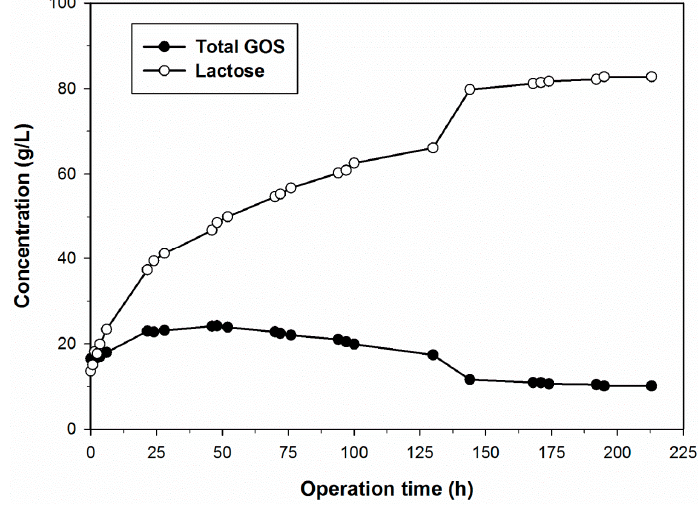
Figure 5. Progress of GOS and lactose concentration during the operation of the PBR (packed ‐ bed reactor) packed with β‐ galactosidase from B. circulans immobilized on glyoxal agarose beads. Reactor conditions: feed solution, 100 g/L lactose; flow rate, 0.2 mL/min; pH 5.5, 45